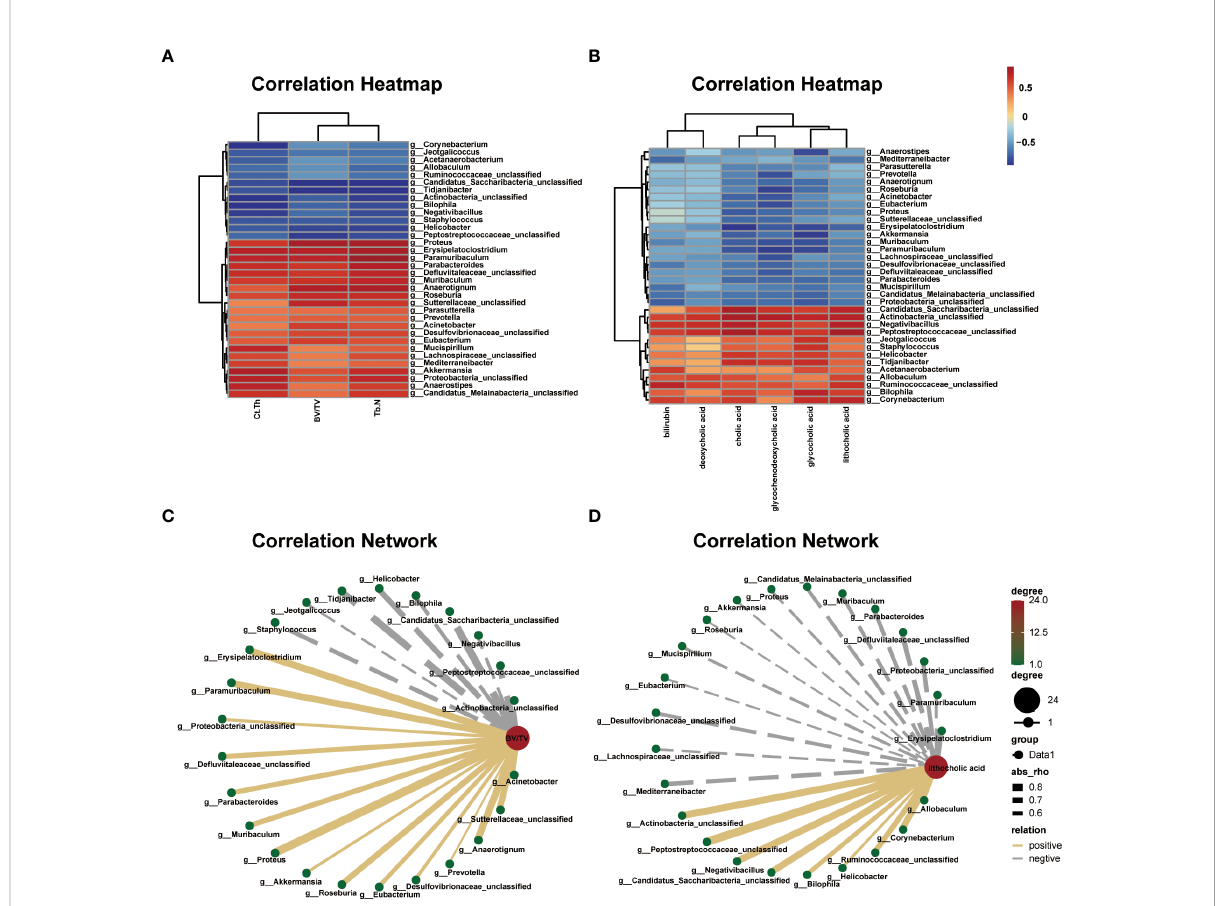
FIGURE 6 Correlations among differential gut microbial genera, bone phenotypes, and fecal metabolites related to bile acid metabolism. (A) Correlation heat between differential bacterial genera and bone phenotypes in the two groups, |r| > 0.5. Red represents positive correlations, and blue represents negative correlations. The darker the color, the stronger the correlation. (B) Correlation network map between BV/TV and differential bacterial genera, |r| > 0.5. (C) Correlation heat map between the differential bacterial genera and fecal metabolites related to bile acid metabolism in the two groups, |r| > 0.5. Red represents positive correlations, and blue represents negative correlations. The darker the color, the stronger the correlation. (D) Correlation network map between lithocholic acid (LCA) and differential bacterial genera, |r| >